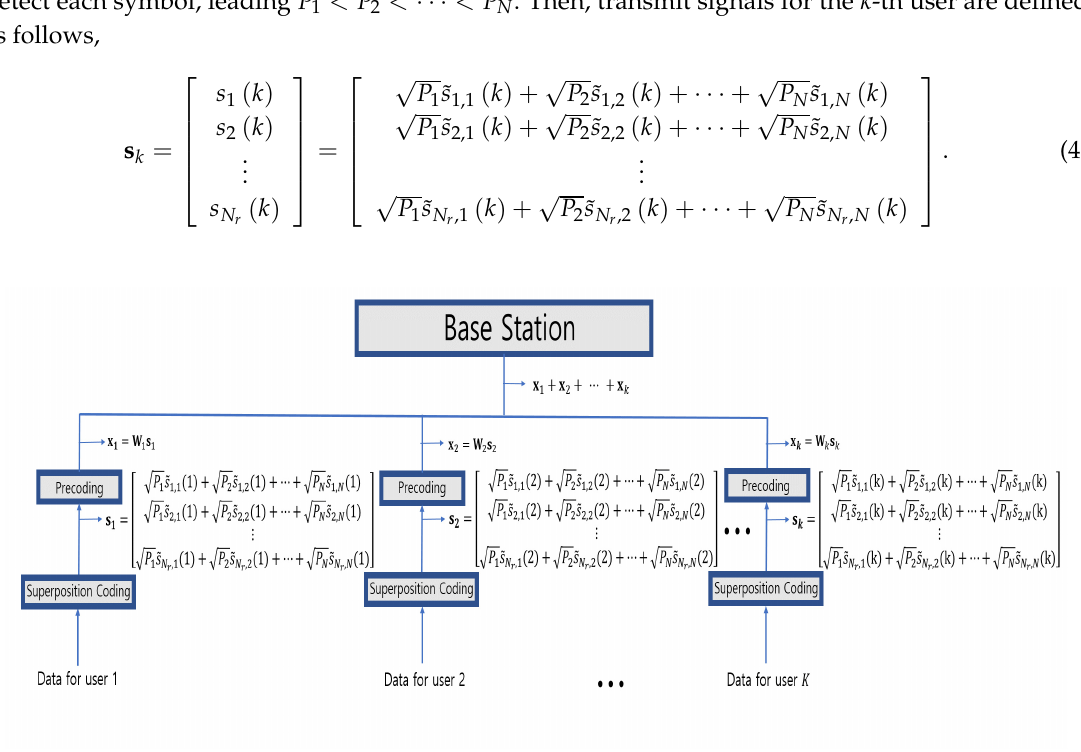
Figure 5. The proposed signal transmission